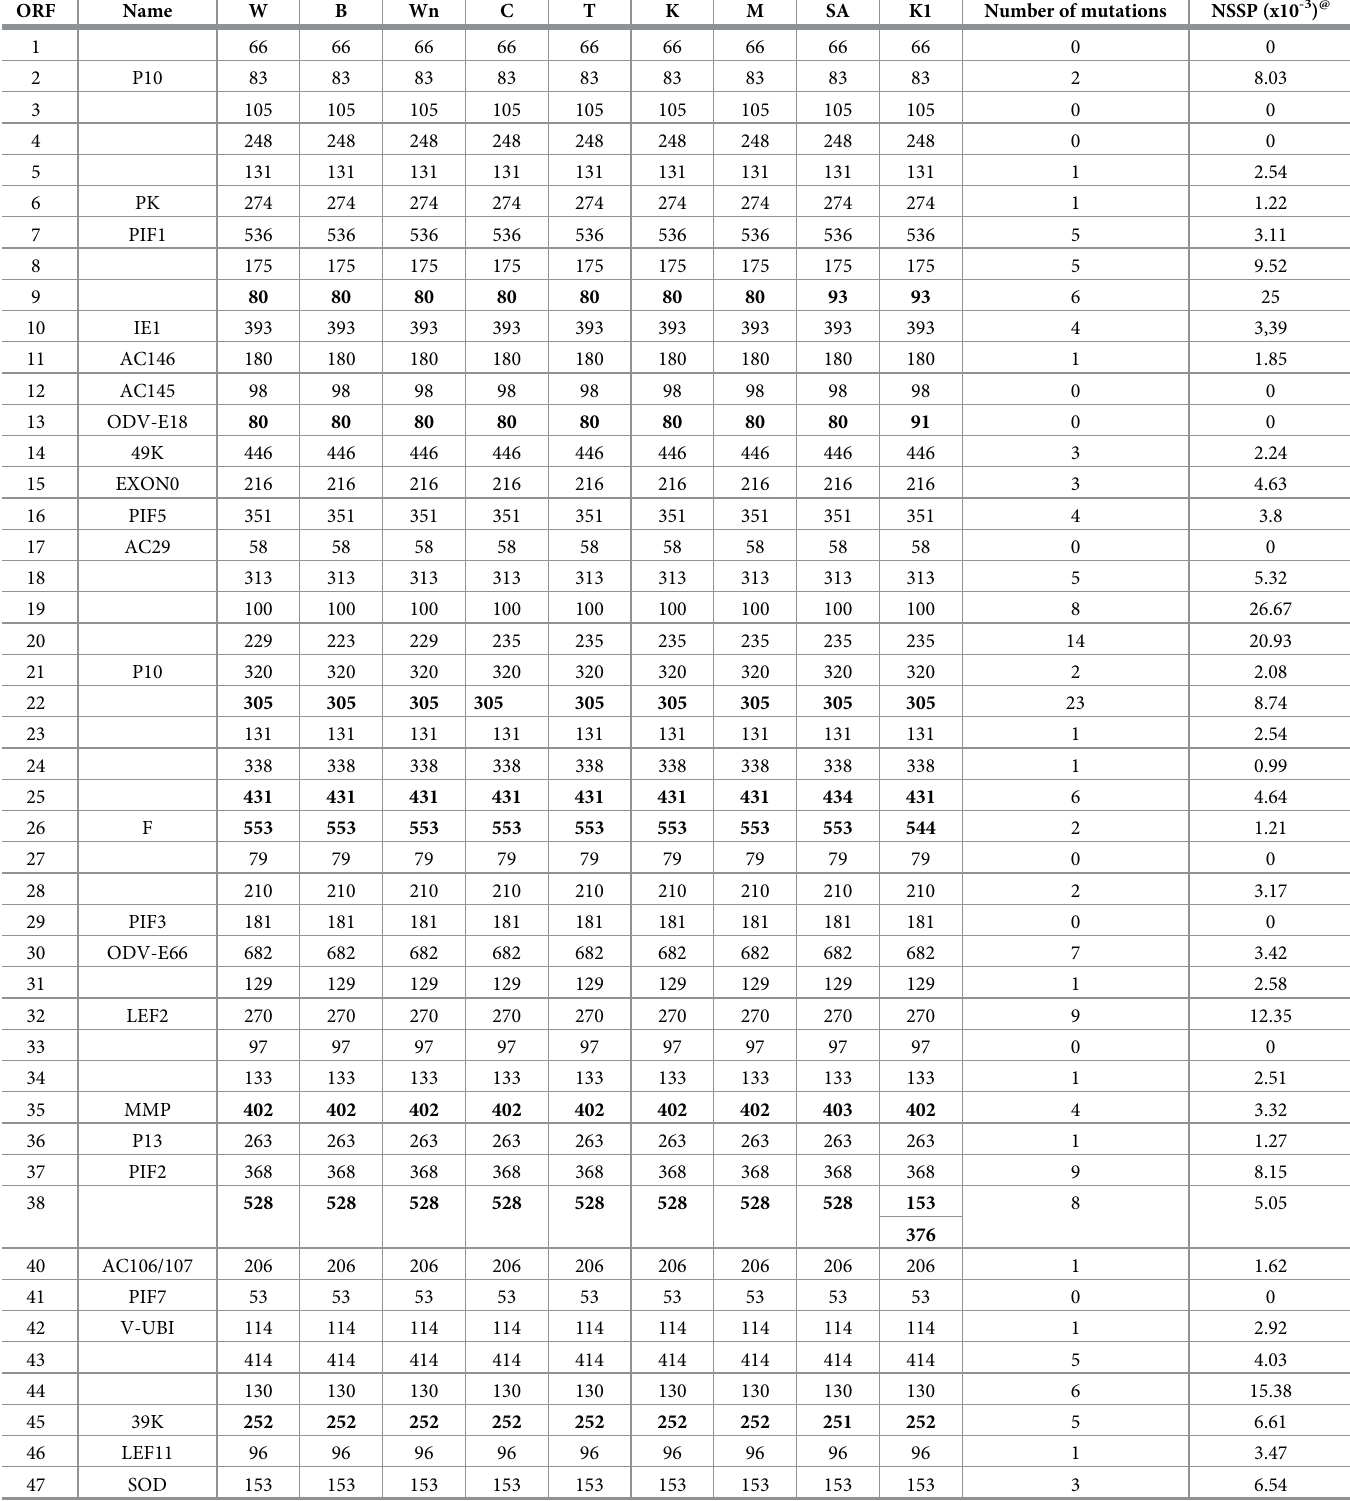
Table 5. ORF size and number of nonsynonymous mutations in nine PlxyGV isolates.